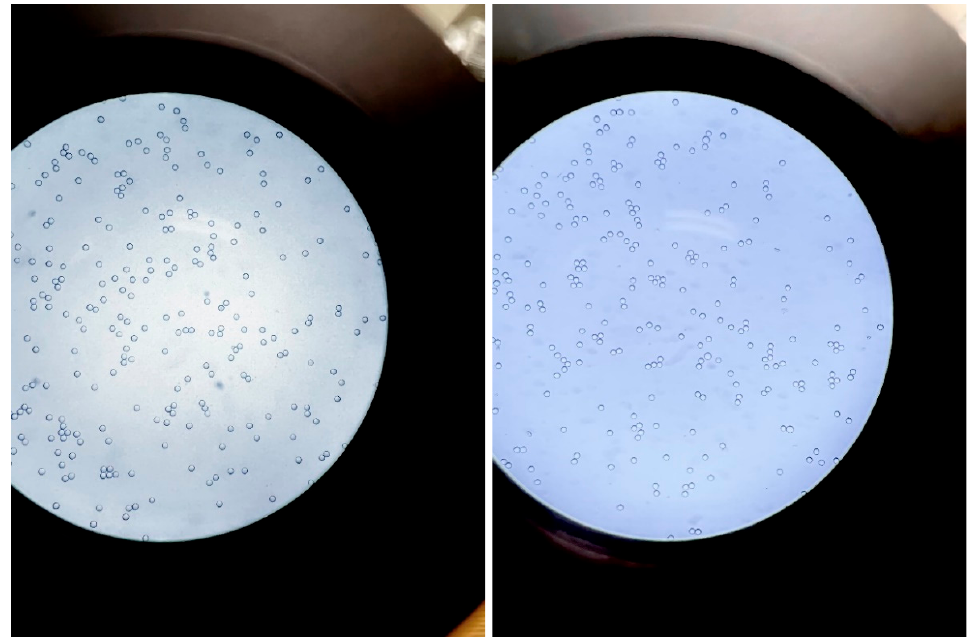
Figure 2. Microscopic images of samples 3 ( Left ) and 5 ( Right ). Microscopic images of 1 , 2 , and 4 samples are provided in the Supplementary Materials.